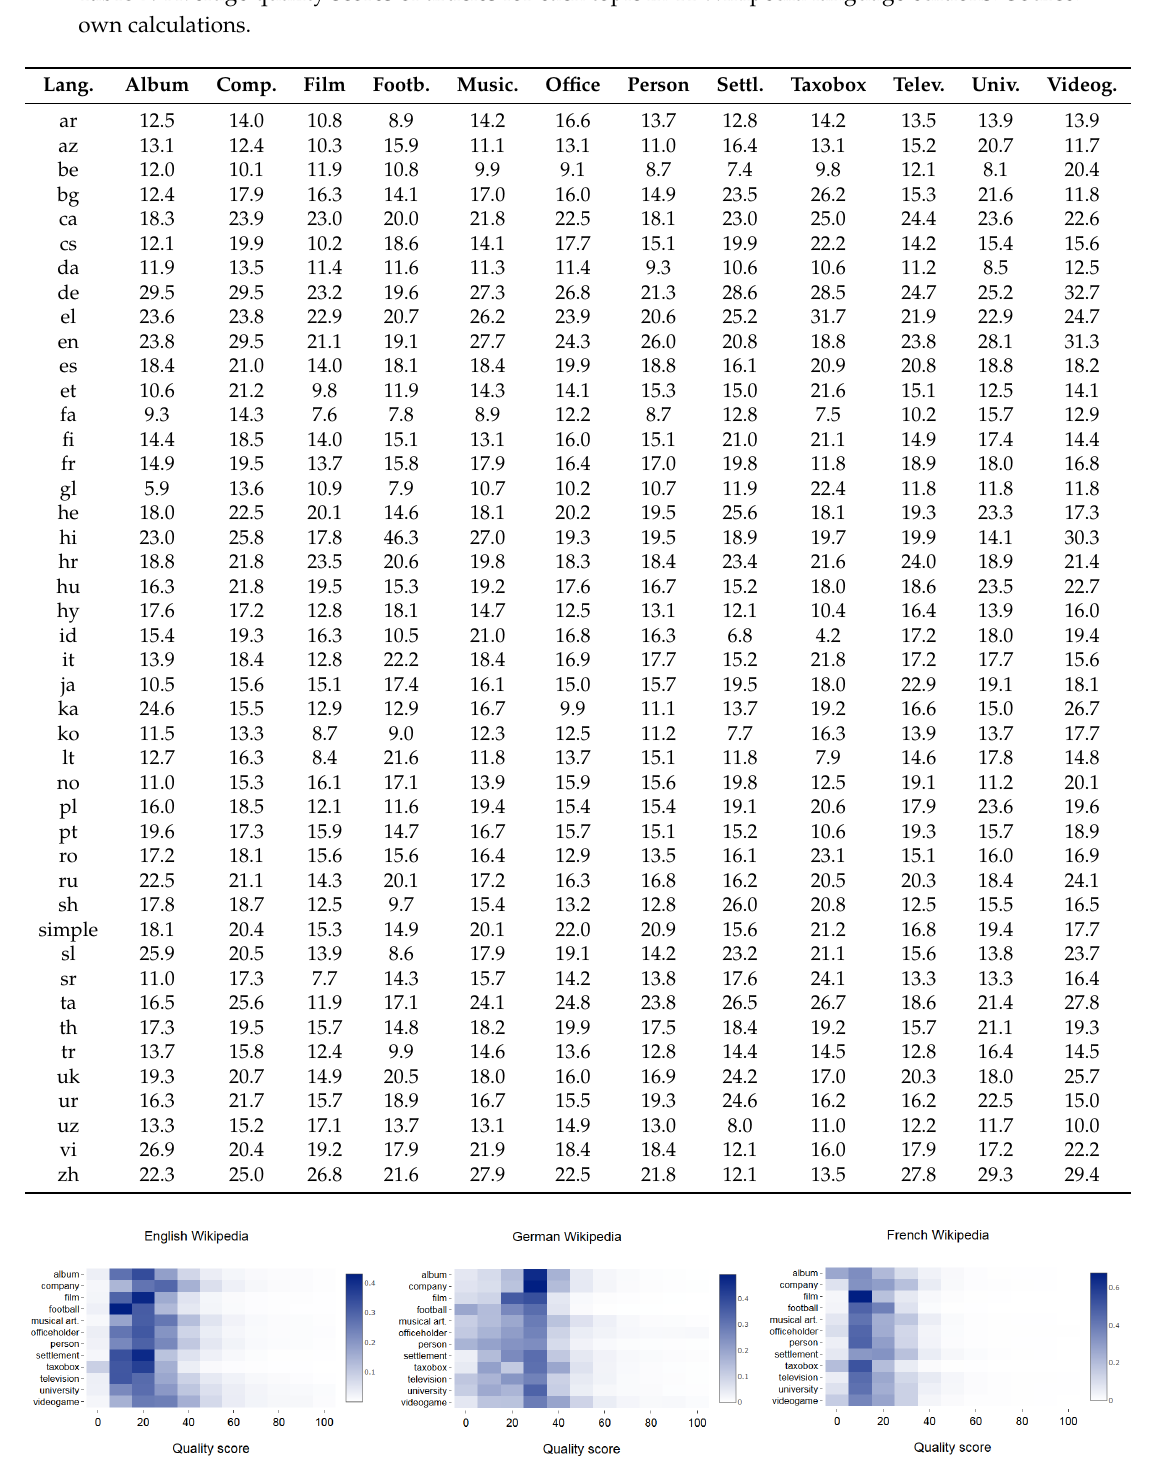
Figure 5. Distribution of quality scores for three Wikipedia language versions (English, German, and French) in 12 considered topics. Source: own